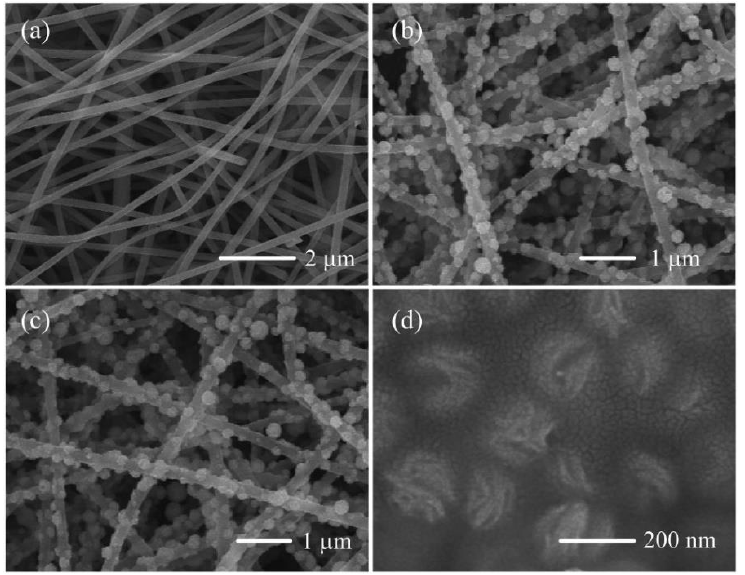
Figure 3. SEM images of ( a ) CNFs, ( b ) MoS 2 @CNFs, ( c ) MoS 2 @CNFs@C, and ( d ) pure MoS 2 NS.